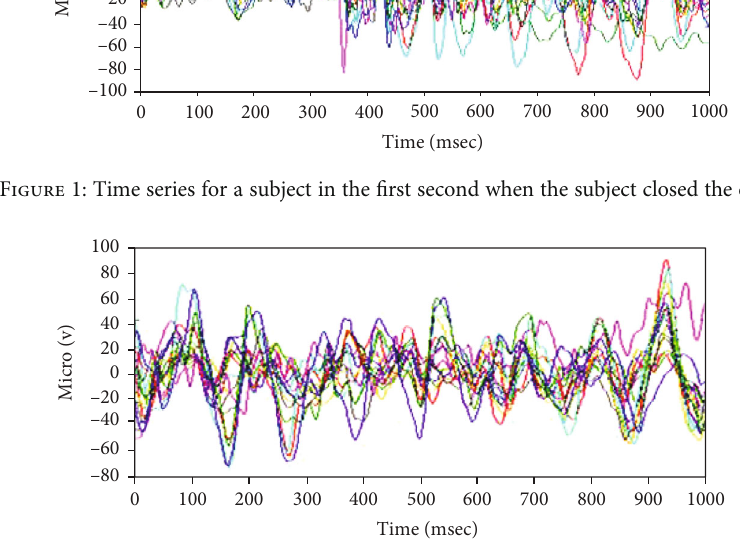
Figure 2: Time series for half second when eyes of the subject were close.